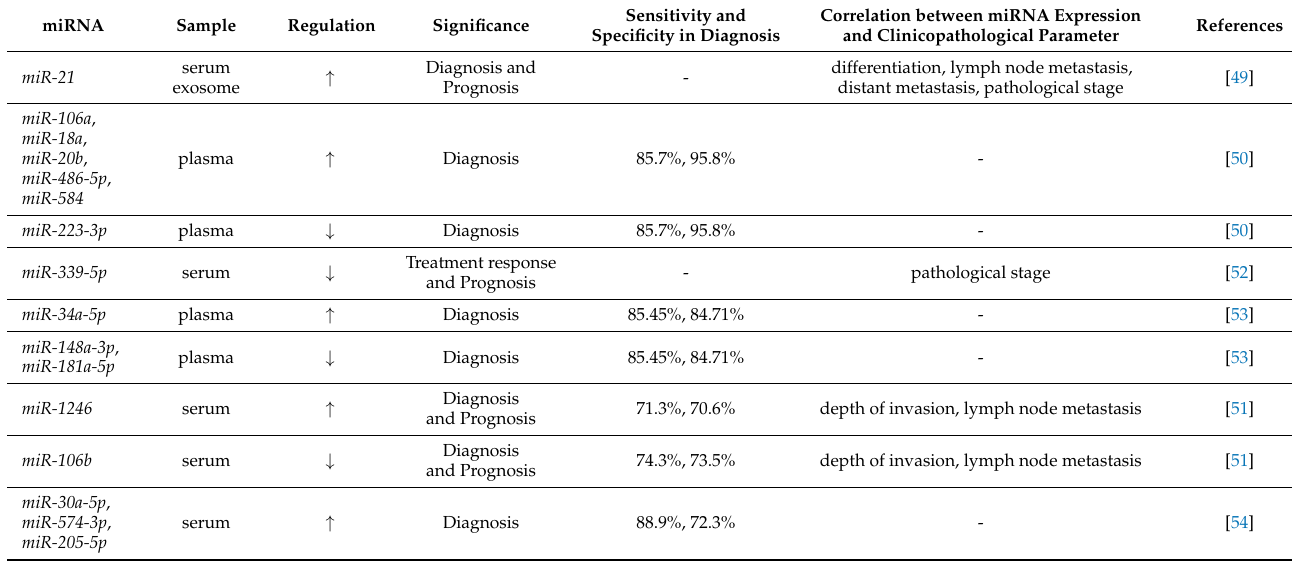
Table 1. Esophageal